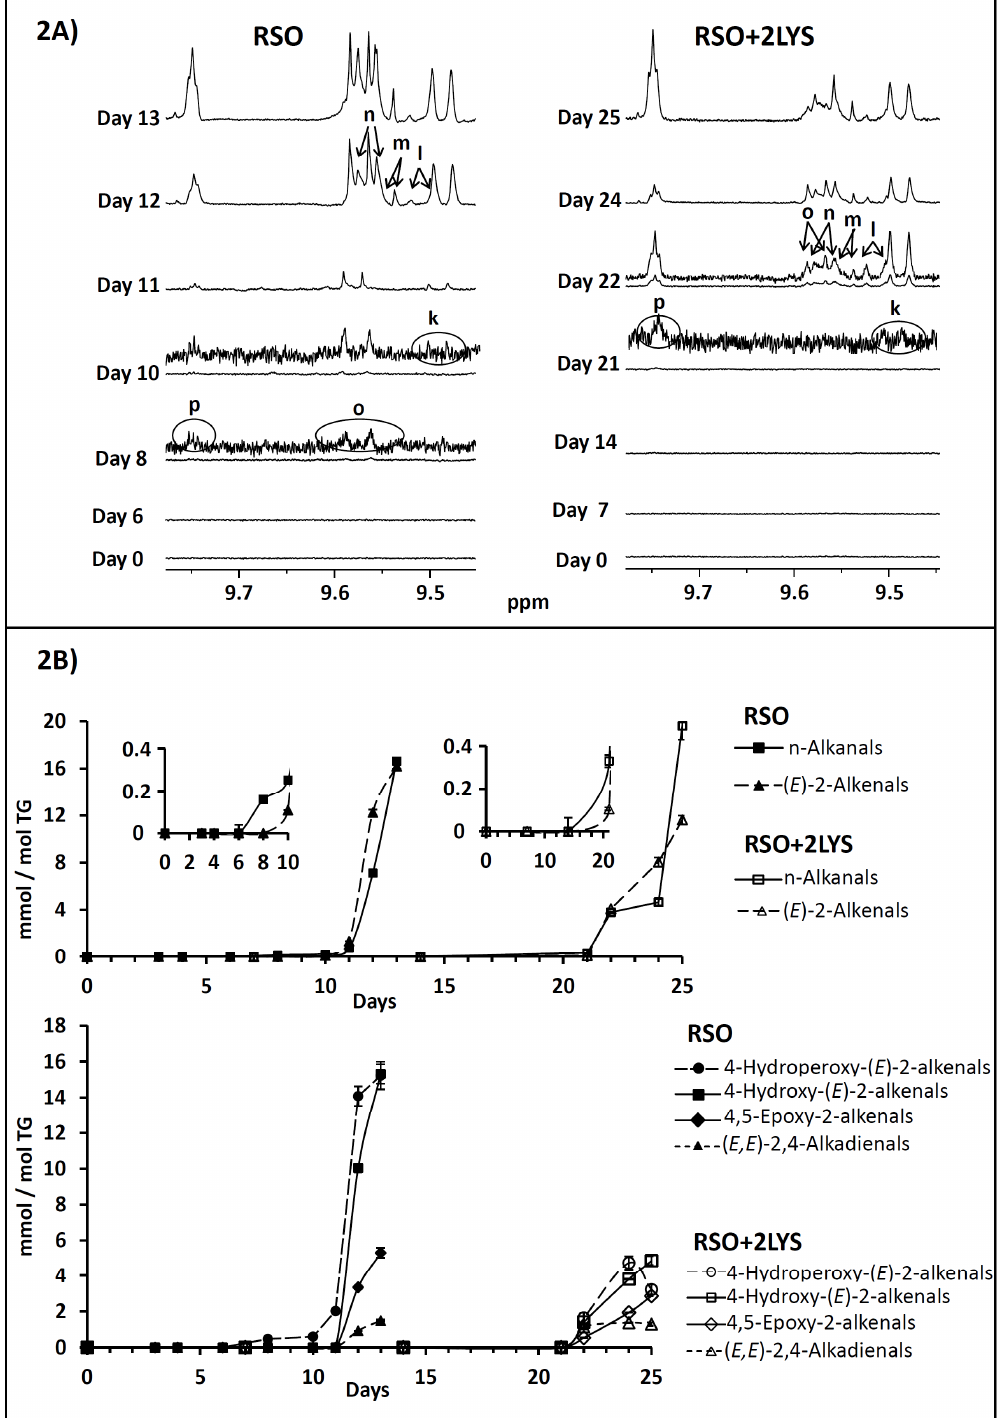
Figure 2. Evolution throughout the oxidation process, in the reference oil (RSO) and in the sample with lysine added (RSO + 2LYS), of: ( A ) the 1 H NMR spectral signals of aldehydes: n -alkanals (signal “p”), 4-hydroperoxy-( E )-2-alkenals (signal “o”), ( E )-2-alkenals (signal “k”), 4-hydroxy-( E )-2-alkenals (signal “n”), 4,5-epoxy-2-alkenals (signal “m”), and ( E,E )-2,4-alkadienals (signal “l”); and ( B ) their respective concentrations, in mmol/mol TG, given as mean values. Letters in Figure ( A ) agree with those in Table S1, and all the plots have been drawn at a fixed value of absolute intensity to be valid for comparative purposes. RSO: refined soybean oil. 2LYS: 2% by weight of L-lysine. TG: triglyceride.